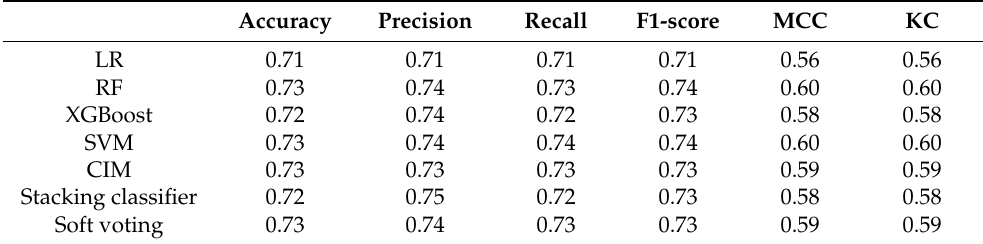
Table 2. Performance comparison of the generated prediction models on the test